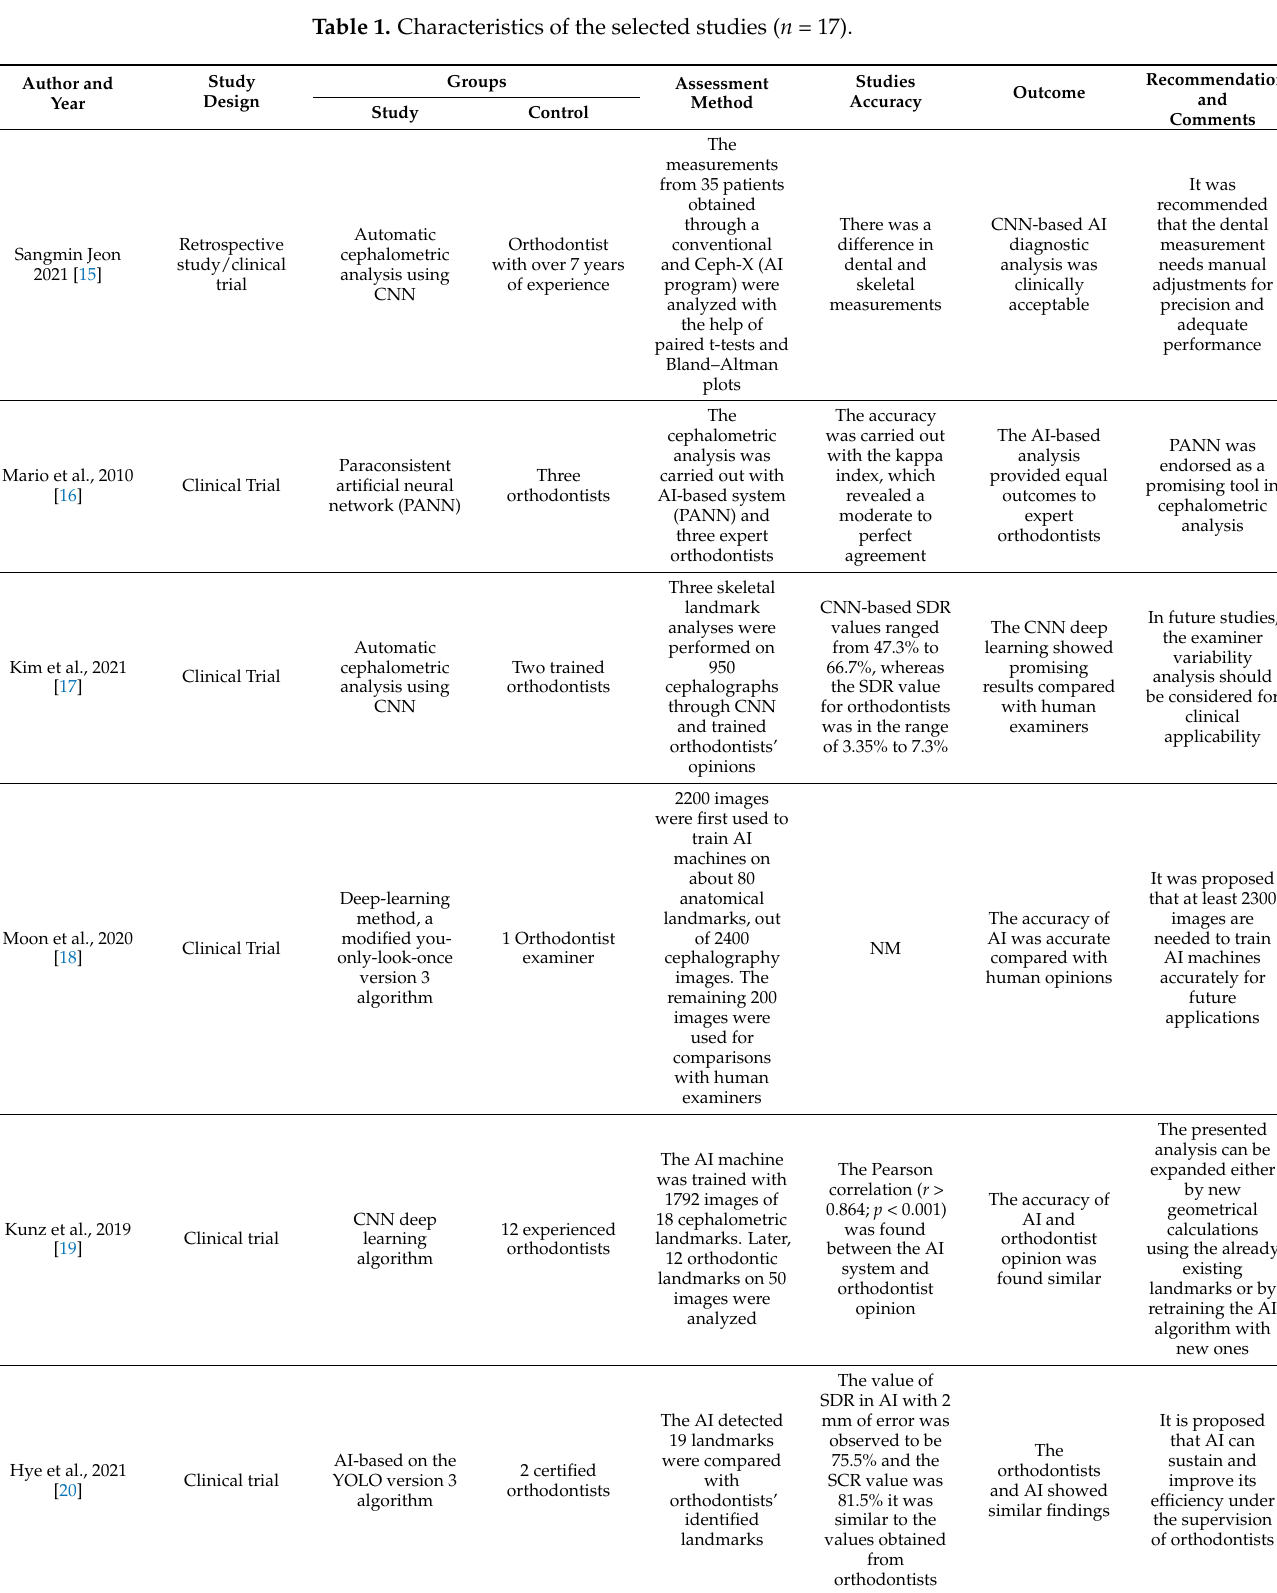
Table 1. Characteristics of the selected studies ( n =